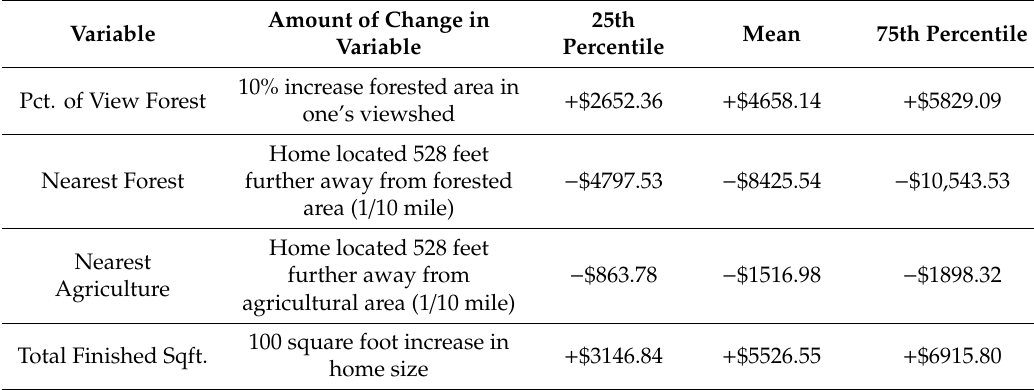
Table 3. Global OLS hedonic willingness to pay estimates of the environmental “focus” variables compared to total finished square footage. Measured via impact on 25th percentile ($104,200), mean ($182,998.40), and 75th percentile prices ($229,000).